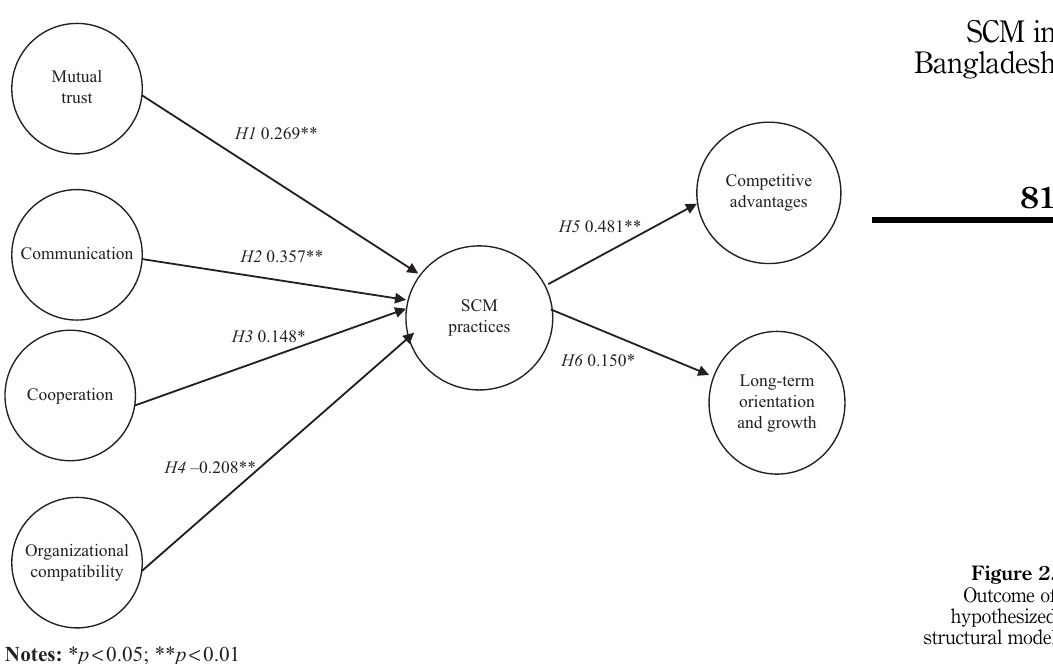
Figure 2. Outcome